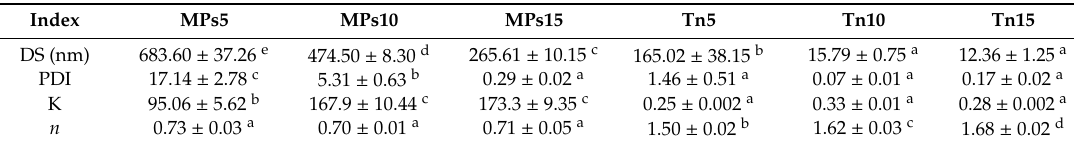
Table 1. The droplet size (DS), polydispersity index (PDI), K, and n of the myofibrillar protein (MP)- or Tween 80-stabilized camellia seed oil